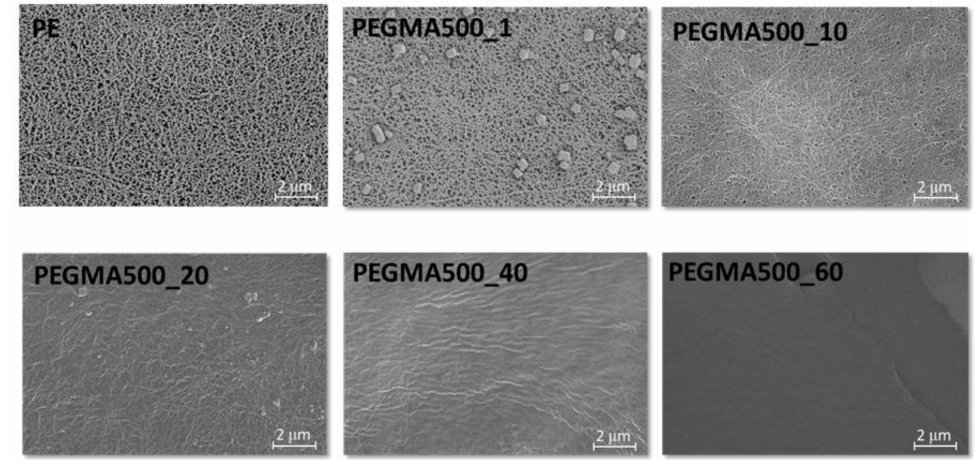
Figure 3. SEM images of the commercial polyethylene (PE) separator and